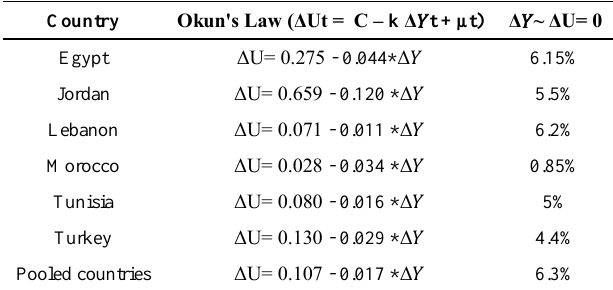
Table 2. Unemployment and Economic growth (Okun'